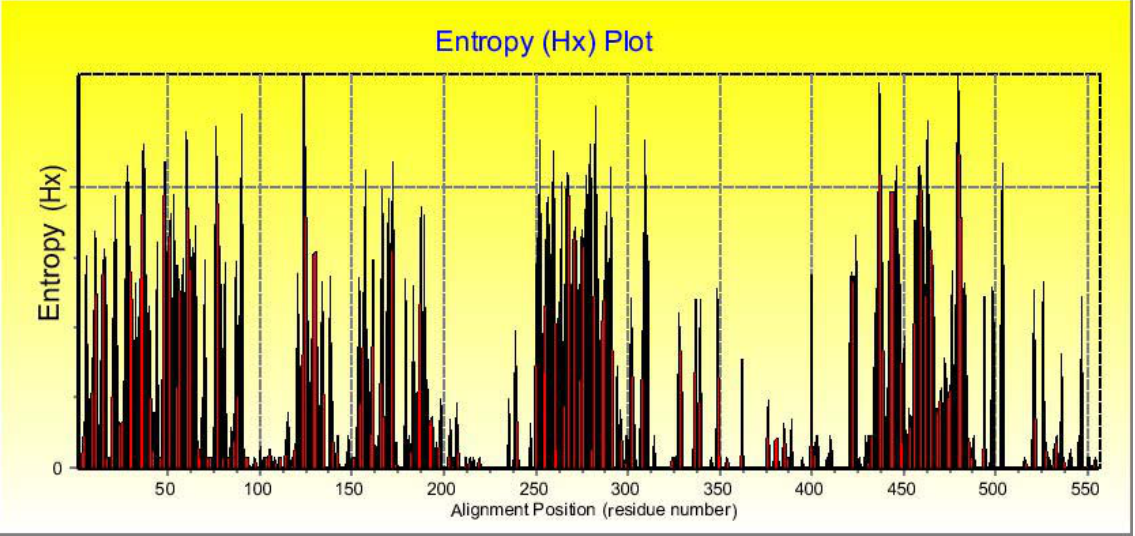
FIGURE 2. Entropy plot for a part of the 16S rDNA gene. The plot is based on 150 partial 16S rDNA sequences obtained from microorganisms on fish samples. The regions with high entropy are variable, while the regions with low entropy are conserved. (Nissen et al., manuscript in